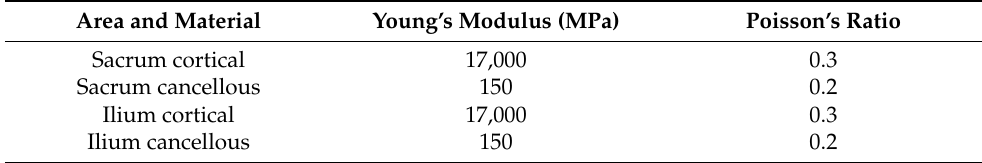
Table 1. Material properties of each part of the skeleton